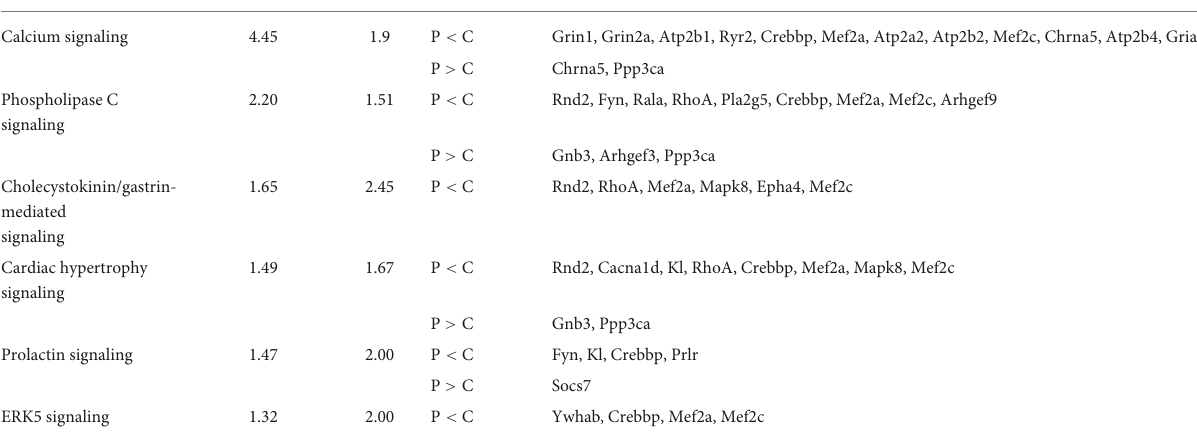
TABLE 1 Enrichment analysis of differentially expressed